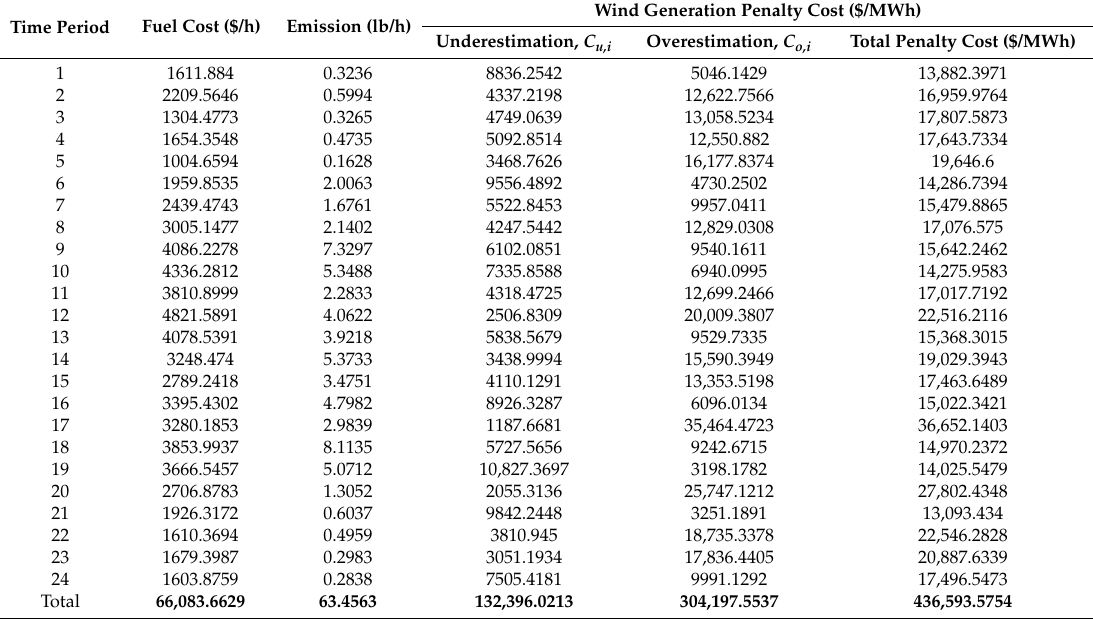
Table 3. Fuel cost, rate of pollutant emission, and wind generation penalty cost of the optimal generation schedule-MPSO